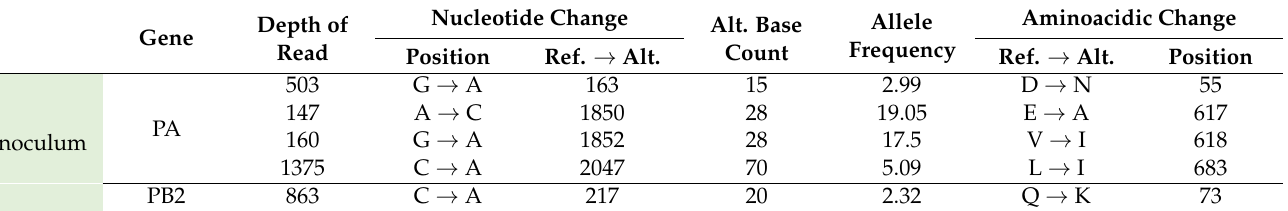
Table 4. SNV detected in the